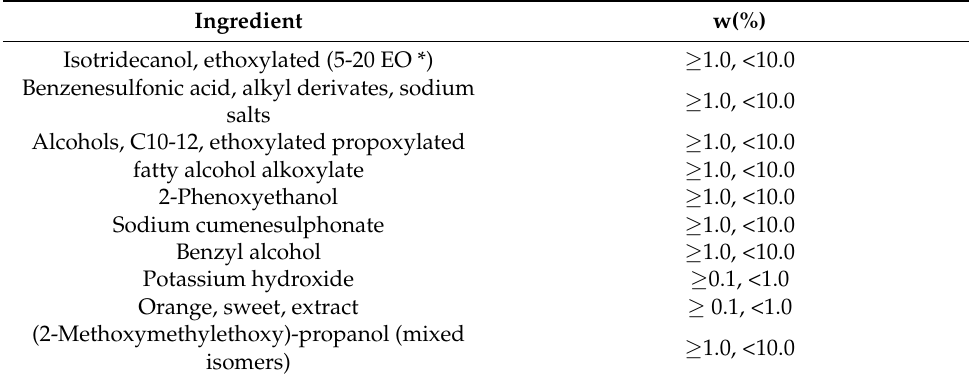
Table 2. Composition of wet cleaning detergent. Ingredient w(%) Isotridecanol, ethoxylated (5-20 EO *) ≥ 1.0, <10.0 Benzenesulfonic acid, alkyl derivates, sodium ≥ 1.0, <10.0 salts Alcohols, C10-12, ethoxylated propoxylated ≥ 1.0, <10.0 fatty alcohol alkoxylate ≥ 1.0, <10.0 2-Phenoxyethanol ≥ 1.0, <10.0 Sodium cumenesulphonate ≥ 1.0, <10.0 Benzyl alcohol ≥ 1.0, <10.0 Potassium hydroxide ≥ 0.1, <1.0 Orange, sweet, extract ≥ 0.1, <1.0 (2-Methoxymethylethoxy)-propanol (mixed ≥ 1.0, <10.0 isomers)